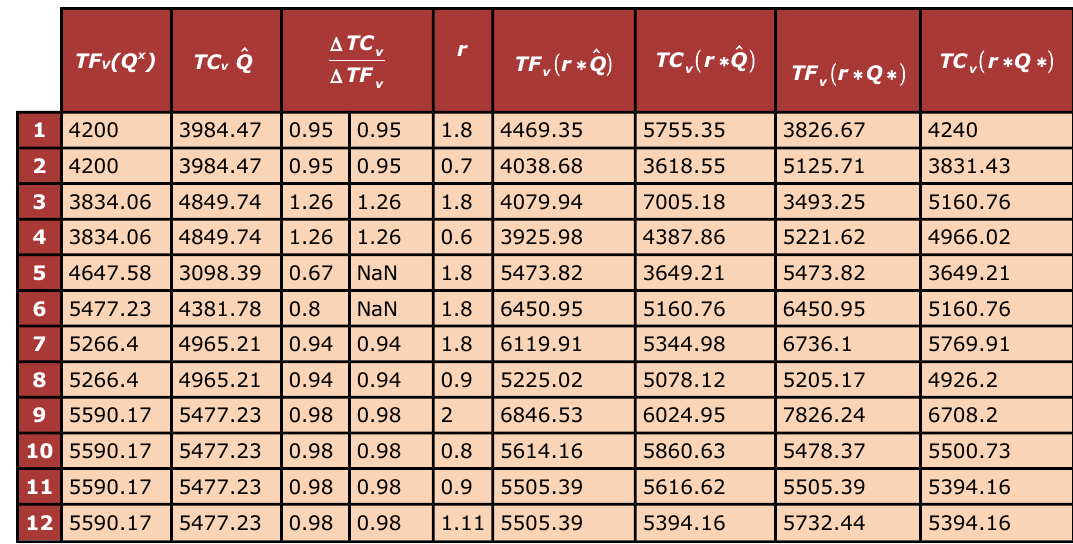
Table 1. Results of the